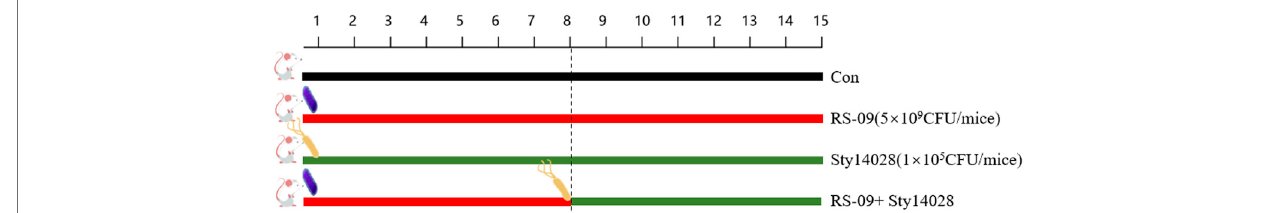
FIGURE 1 | Experimental design of the mouse study.